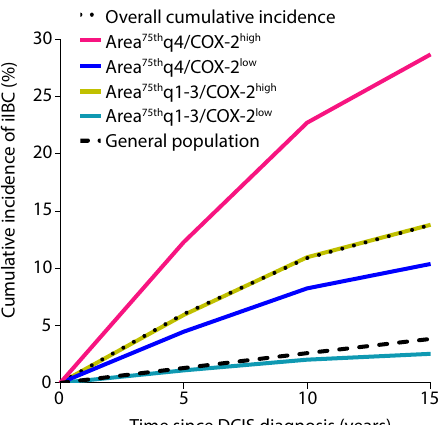
Fig. 4 Estimated cumulative incidence of subsequent iIBC in DCIS for a combination of adipocyte area 75th and COX-2 status. Estimated cumulative incidence of iIBC per category of adipocyte area 75th /COX-2 status among women with primary DCIS treated by BCS alone. Cumulative incidence of subsequent iIBC by adipocyte area 75th and COX-2 status was estimated using the ORs for adipocyte area 75th and COX-2 status from the current study. The cumulative risk of iIBC and death due to other causes was derived from the full